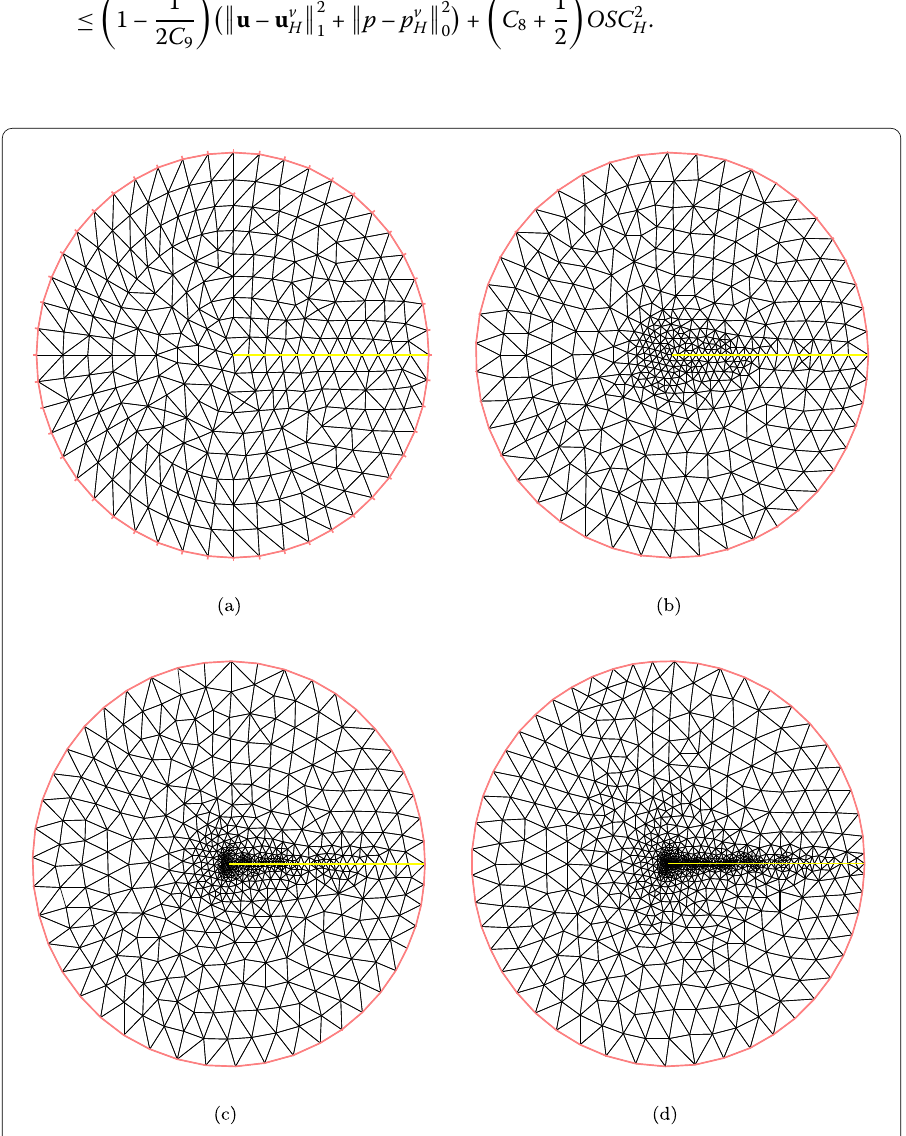
Figure 3 The mesh in adaptive computation. ( a ) Initial mesh. ( b ) Mesh after step 1. ( c ) Mesh after step 2. ( d ) Mesh after step